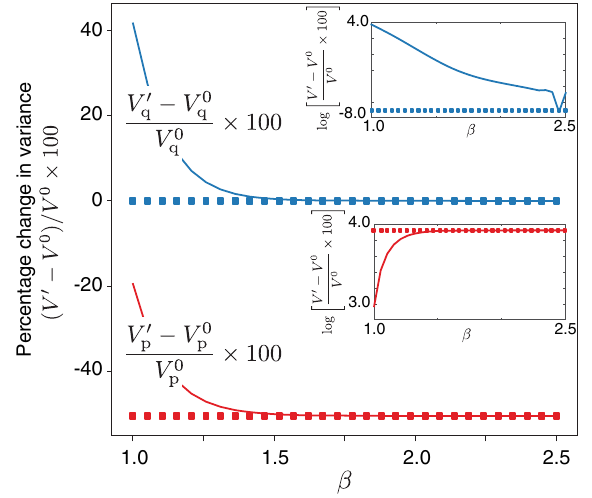
T Þ FIG. 8. Percent change in the Holevo phase variances V 0 q;p ð for different sizes of the PCO cat state β and fixed g ¼ 0 . 02 K for ˆ S one round of phase estimation of . The Kerr nonlinearity of the p PCO is fixed, and the two-photon drive strength is varied as P ¼ K β 2 so that the cat states with amplitude β are stabilized. The solid lines show the change in variance in the ˆ p (red) and ˆ q (blue) quadratures. The dashed lines are the corresponding variances when phase estimation is carried out with an ideal two- ˆ S is being measured, the variance V 0 level system. Since p p − V 0 < 0 ), while the variance V 0 decreases (that is, V 0 remains p p q − V 0 0 ). As expected, for large β , the unchanged (that is, V 0 q q ¼ solid and dotted lines converge, and the APE protocol with the PCO becomes ideal.